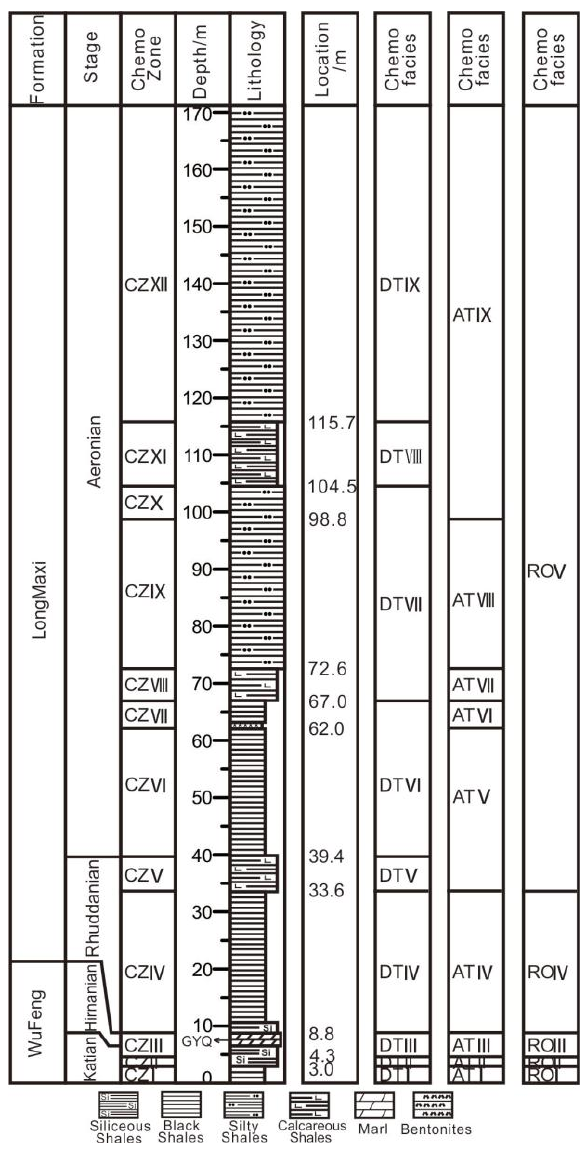
Figure 6. The unified chemostratigraphic scheme of the Changning section.